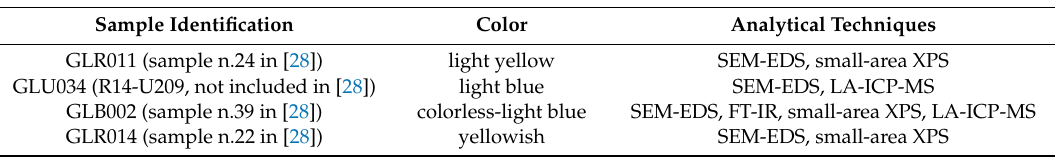
Table 1. Analyzed glass samples: together with the color, the analytical techniques employed for the characterization of each sample, are here listed.